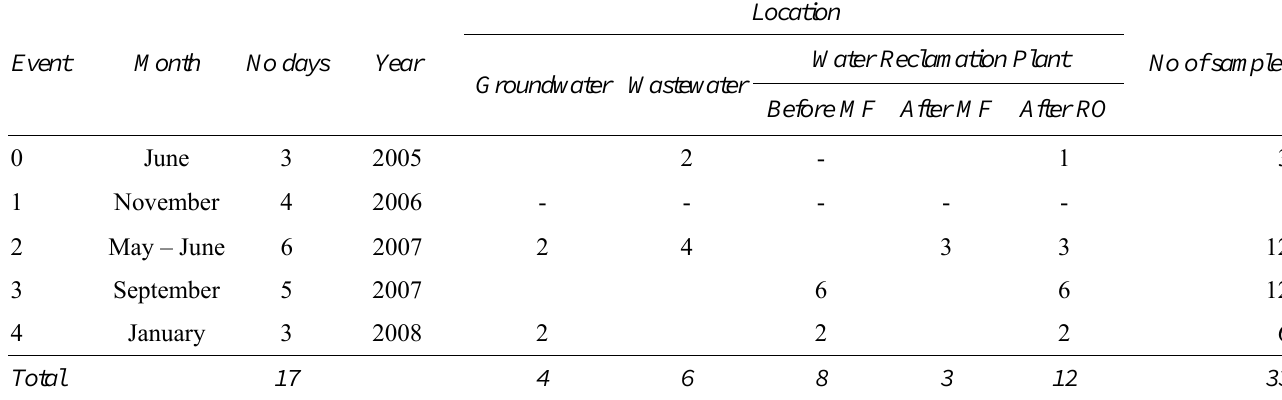
MF Microfiltration, RO Reverse Osmosis